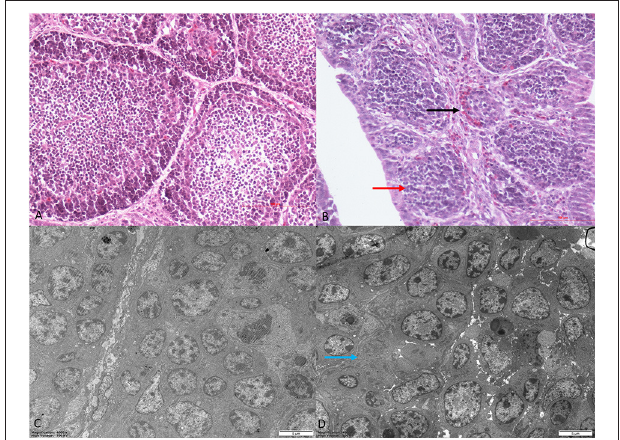
FIGURE 1 | Histological and ultrastructural changes in chicken bursa of Fabricius after reticuloendotheliosis virus (REV) infection. Histological examination of the bursa of Fabricius in the control group (A) and REV infection group (B) by H&E staining (200 × ). Histology results showed hyperplasia of the reticular endothelial system (black arrow) and reductions in cortical lymphocytes (red arrow) in the REV infection group. Transmission electron microscopy of the bursa of Fabricius in the control group (C) and REV infection group (D) (4,000 × ). Ultrastructural results showed that the REV infection group exhibited apoptosis and necrosis (blue